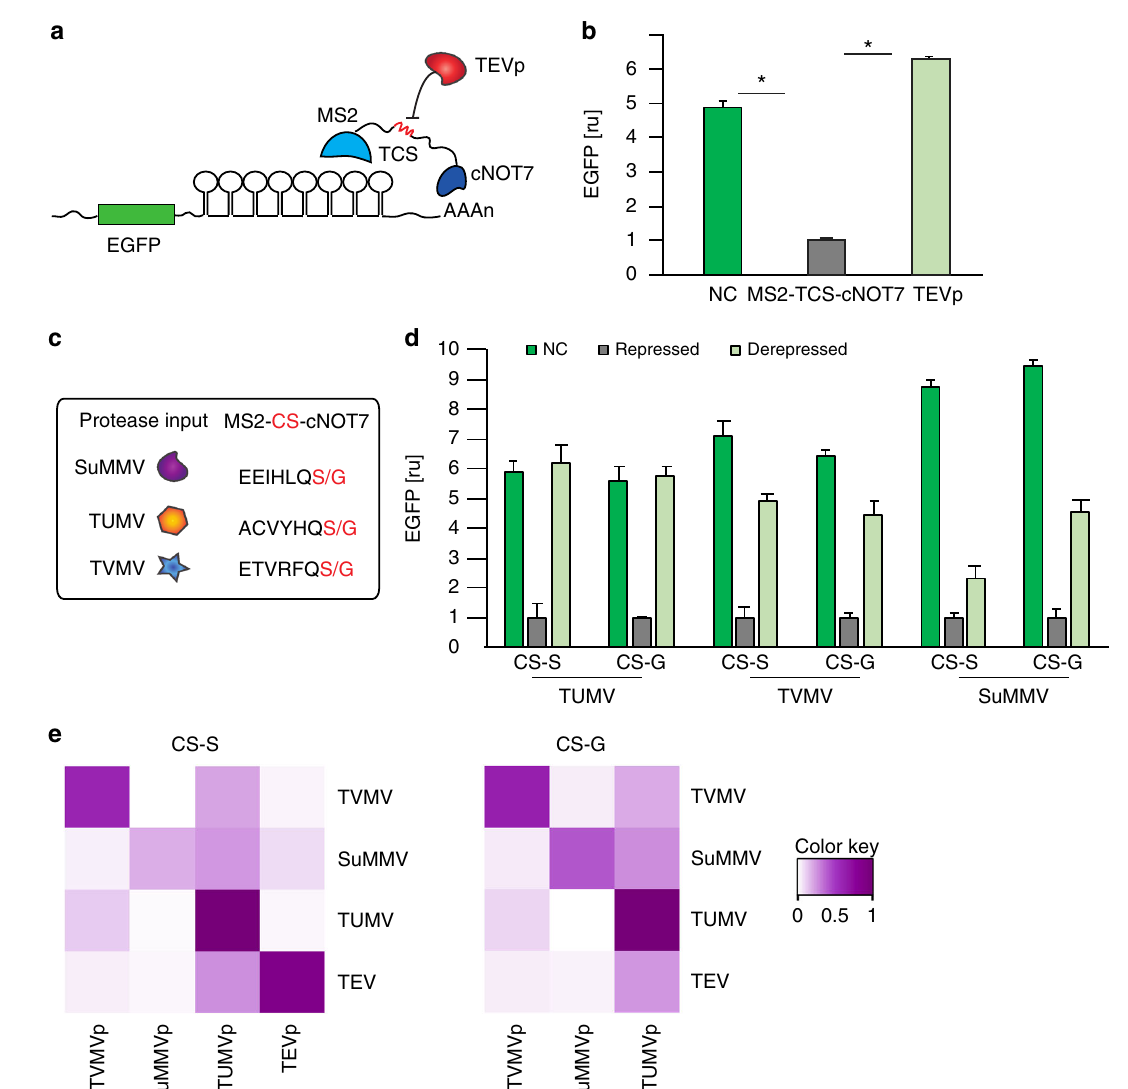
Fig. 3 Engineering protease-dependent MS2-cNOT7 proteins. a Schematics of the cascade. MS2 is fused to cNOT7 via the TEVp cleavage site (MS2-TCS- cNOT7). MS2 binds its cognate sequences in the 3 ’ UTR of target EGFP mRNA, resulting in RNA de-adenylation by cNOT7. When TEVp is co-expressed, MS2-TCS-cNOT7 is cleaved and the two domains are separated, rescuing EGFP translation. b Flow cytometry data of the protease cascade. MS2-TCS- cNOT7 shows repression similar to its wild-type counterpart MS2-cNOT7 (Supplementary Figure 10). EGFP translation recovers in the presence of